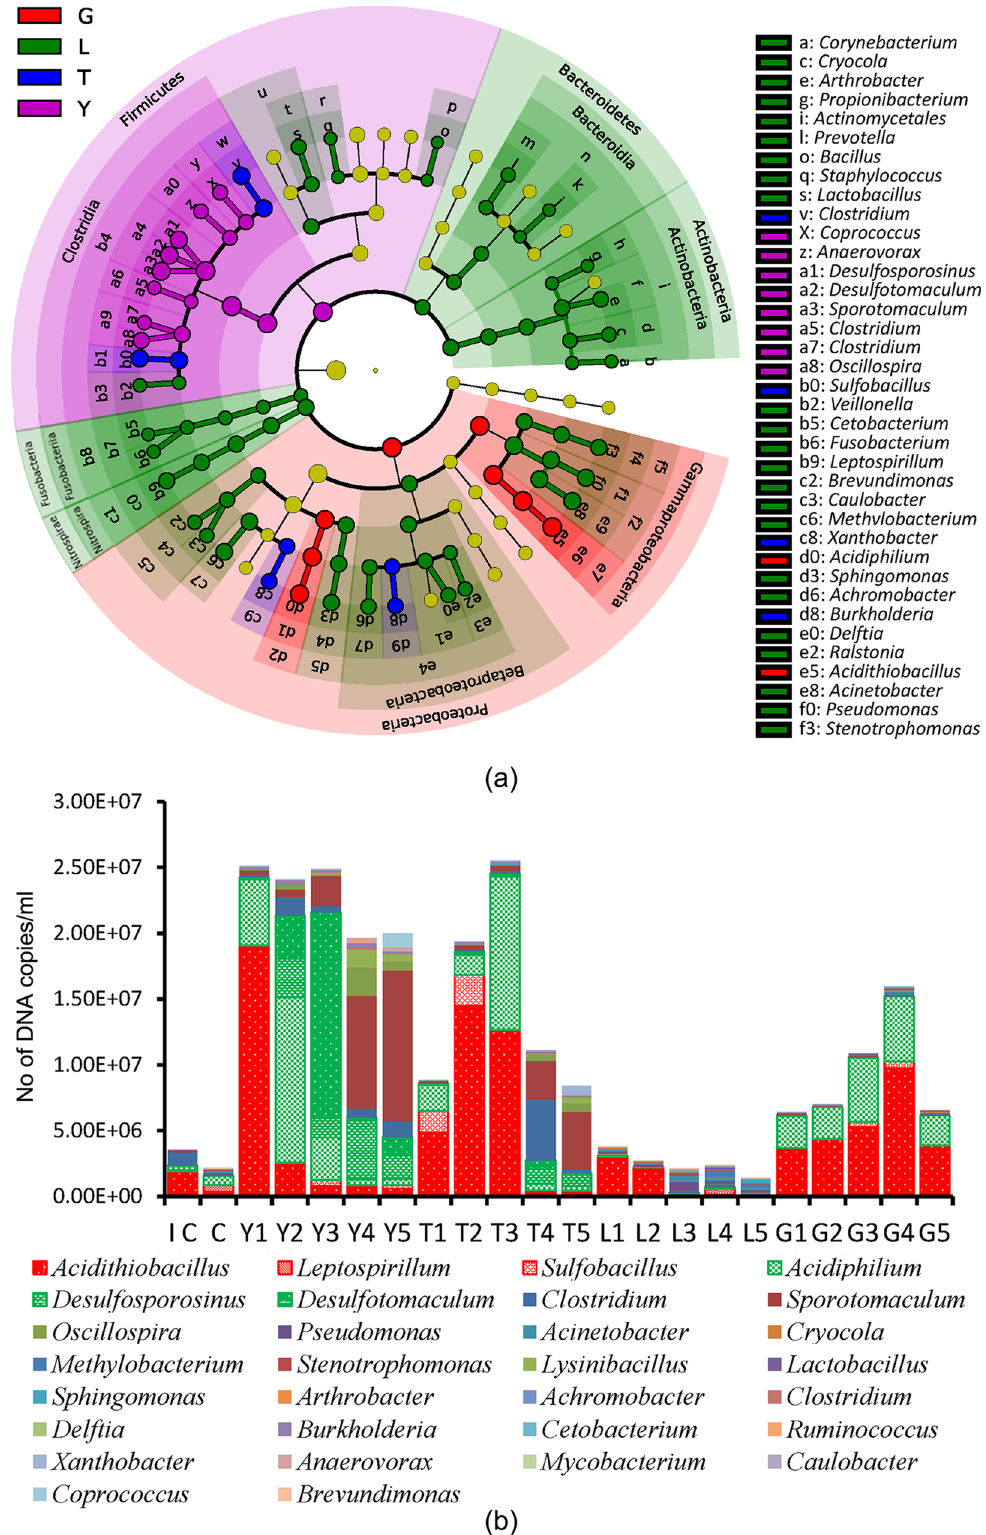
Figure 3. Effects of different nutrients on the microbial community. Linear discriminant analysis effect size (LEfSe) results of the main microbes ( a ). The microbial community and the biomass of the main microbes after 40 days of remediation. IC is the initial control